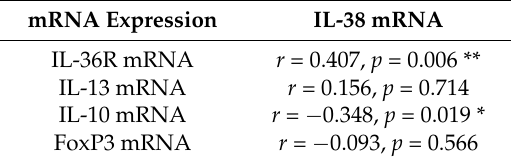
Figure 4. Correlations between serum IL-38 concentrations with peripheral regulatory T lymphocytes in asthmatic patients with high level of serum periostin (>40 ng/mL). n = 13. Correlation was determined by non-parametric Spearman’s correlation test. Table 2. Correlations between mRNA levels of IL-38 with IL-36R, IL-13, IL-10 and FoxP3 in all asthmatic patients with or without steroid treatment. Correlation was determined by non-parametric Spearman’s correlation test.